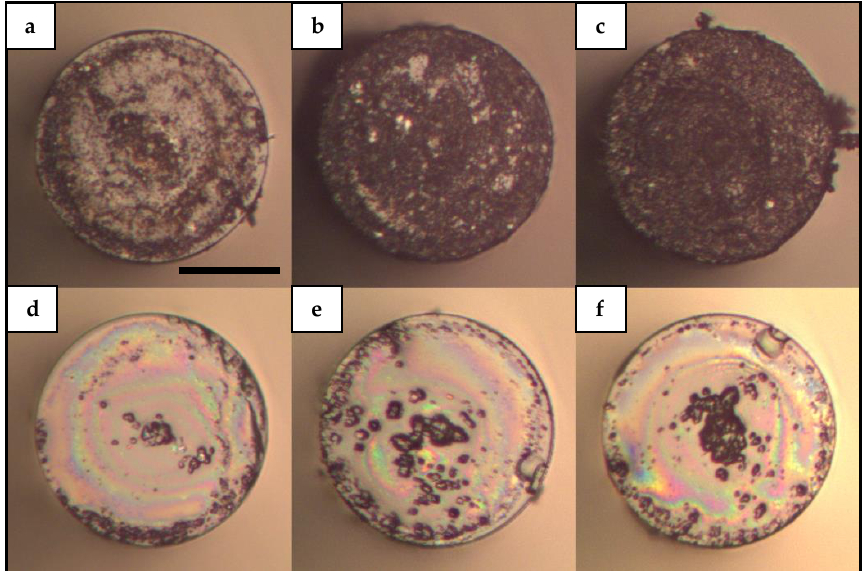
Figure 4. Laser-induced deposition of CNTs with different laser power: ( a ) M-SW sample at 40.0 mW; ( b ) M-SW sample at 88.3 mW; ( c ) M-SW sample at 139.1 mW; ( d ) M-SW-PVP sample at 40.0 mW; ( e ) M-SW-PVP sample at 88.3 mW; ( f ) M-SW-PVP sample at 139.1 mW. The images were taken using an optical microscope with a 20 × microscope objective. The reference bar in panel ( a ) corresponds to 60 µ m.